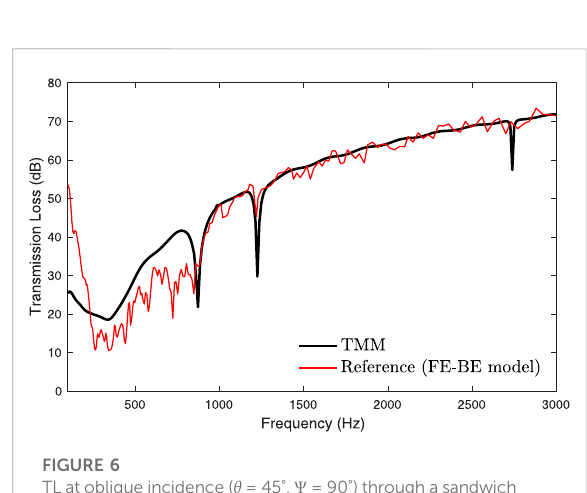
FIGURE 4 TL at oblique incidence ( θ = 45 ° , Ψ = 0 ° ) through a sandwich shell ( r i = 1 m, L = 1 m, δ = 90 ° ).